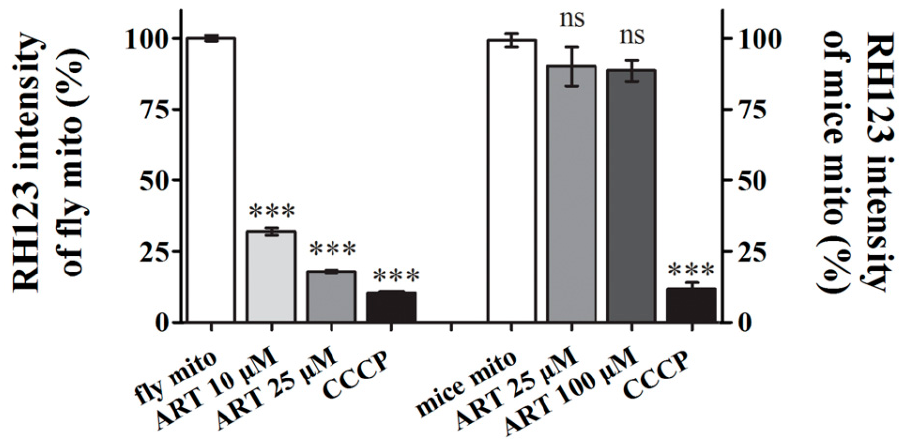
Figure 4. ART is a potent Drosophila mitochondrial depolarizer. ART selectively depolarizes Drosophila mitochondria but not mice mitochondria. Mitochondria isolated from Drosophila and mouse brains were respectively treated with two concentrations of ART. ∆ ψ (mitochondrial membrane potential) was monitored by the fluorescence intensity of rhodamine 123 (Rh123). A higher fluorescence intensity of stained cells indicates a higher ∆ ψ . CCCP (Carbonyl cyanide 3-chlorophenylhydrazone) was used as the positive depolarizer control. ART treatment resulted in a dramatic loss of ∆ ψ in Drosophila mitochondria but little effect on the mammalian mitochondria even at a much higher concentration. Data are shown as mean ± SEM. n ≥ 5. *** p < 0.001. ns: no significance.